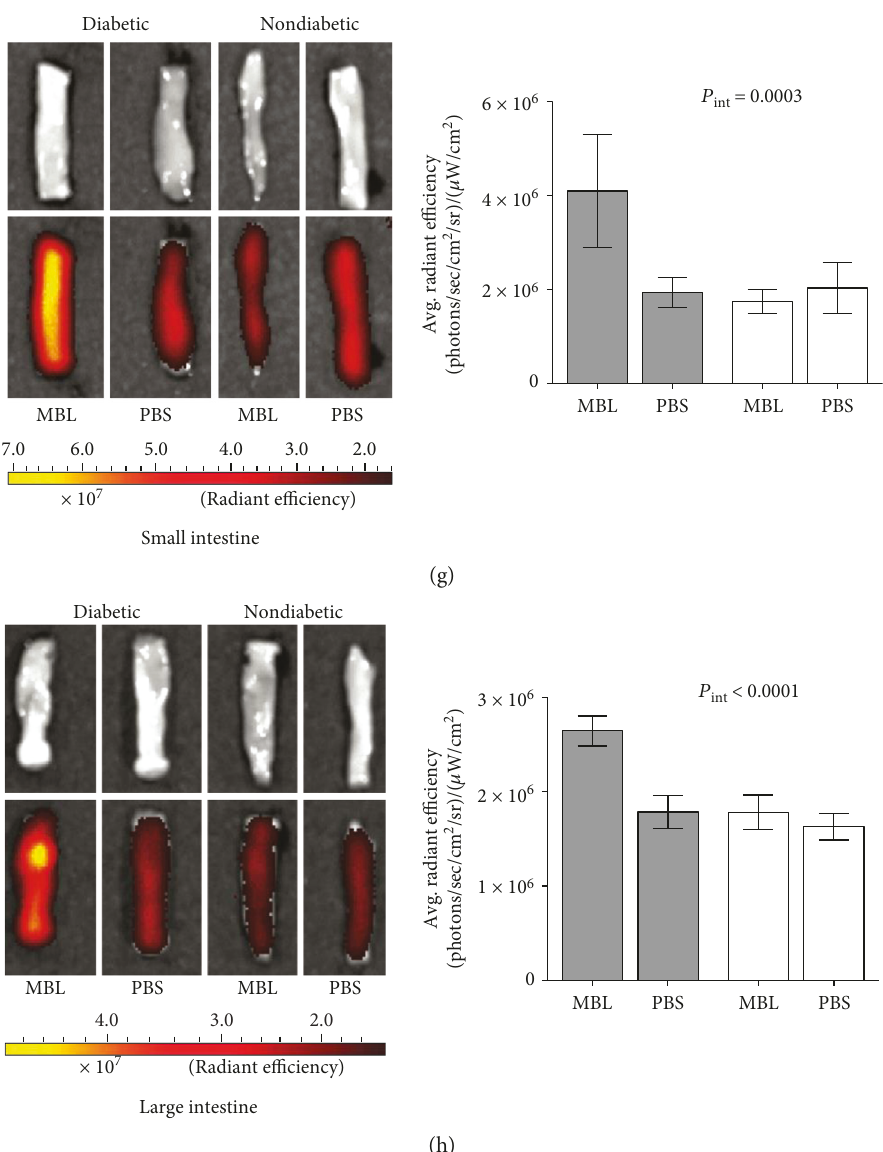
Figure 5: Ex vivo imaging and region of interest (ROI) quanti fi cation of selected organs from diabetic and nondiabetic mice injected with either AF680-labelled rMBL or PBS. (a) Heart, (b) liver (right lobe), (c) brain, (d) spleen, (e) lung (superior left lobe), (f) part of the pancreas, (g) part of the small intestines, (h) and part of the large intestines. Left side, top: CCD photo, bottom: fl uorescent image. Scale bar is given in radiant e ffi ciency (photons/sec/cm 2 /sr)/( μ W/cm 2 ). Two-way ANOVA was used to test the di ff erence between groups ( P Data is expressed in mean with standard deviations (SDs). Images are presented as CCD camera photo and fl uorescence images. The experiment was repeated twice, and the data is based on 6 individual mice in each group ( n = 24 total). Data was obtained with similar